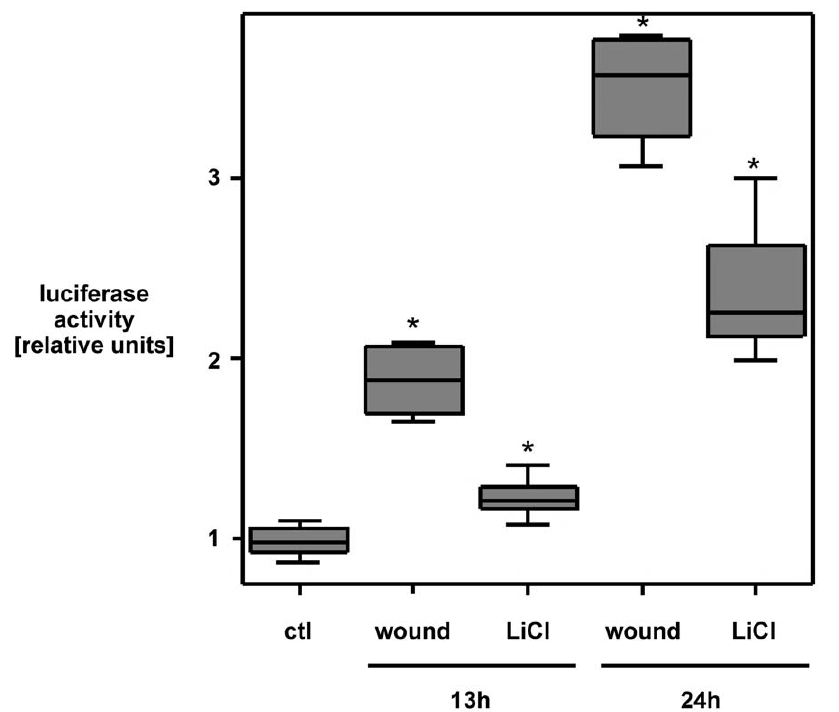
Figure 2. Wounding strongly induces TCF/LEF-dependent gene transcription in IEC18 cell monolayers as compared to control- treated cells. IEC18 cells were grown to confluency, transfected with a TOP/FOP-reporter plasmid (expressing the luciferase gene under the TCF/LEF promoter) and then wounded by multiple scraping. Cell extracts were prepared after 13 h and 24 h, and luciferase activity was determined in cell lysates and normalized for protein content in the respective wells. The GSK3ß inhibitor Lithium Chloride (LiCl, 20 mmol/l) was used as positive control. Data are expressed as median and interquartile range (IQR) of n=3–4 independent experiments, each with three separate wounds/dishes per condition, and luciferase activity was adjusted for total protein content of the respective cell lysates. Statistical analysis was performed by the Kruskal- Wallis test for non-parametric data (*p , 0.05 versus control). Wounding led to a strong, time-dependent induction of luciferase activity as compared to control-treated cells, indicating TCF/LEF-dependent gene